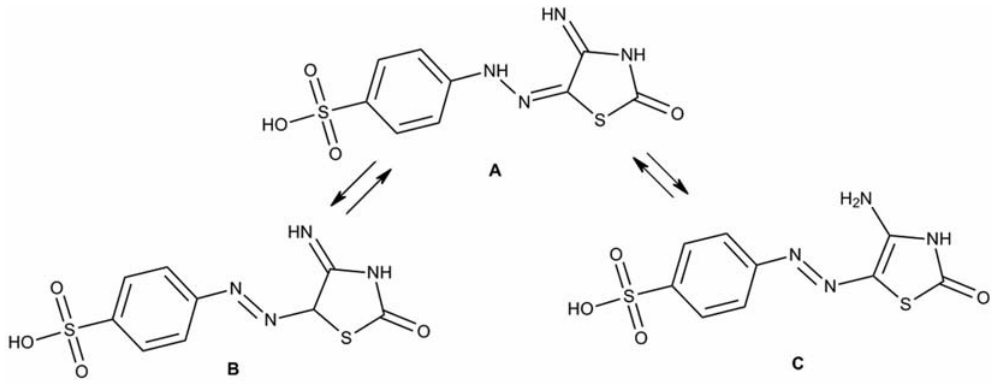
λ = 460 nm. Beer’s law is obeyed at 256 nm and 382 nm (pH = 5.0) over a wide concentration range (Fig. 2).